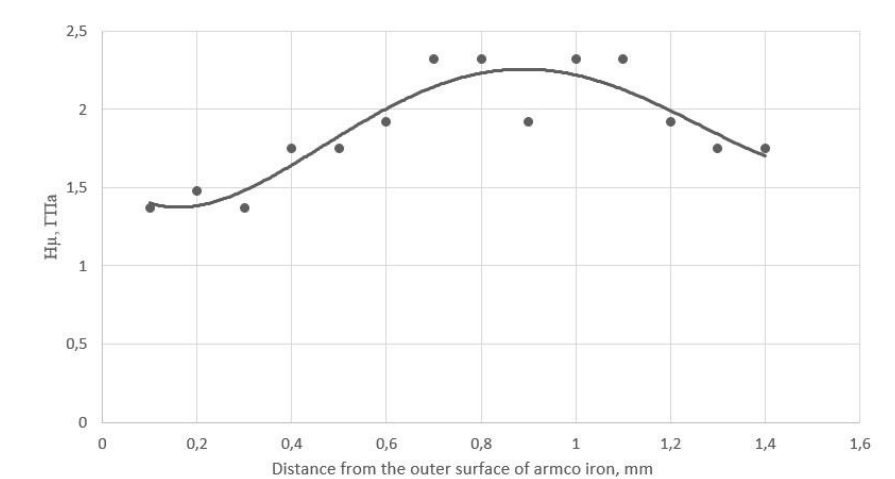
Fig.2. Distribution of microhardness in the sample of a point welded connection of raw